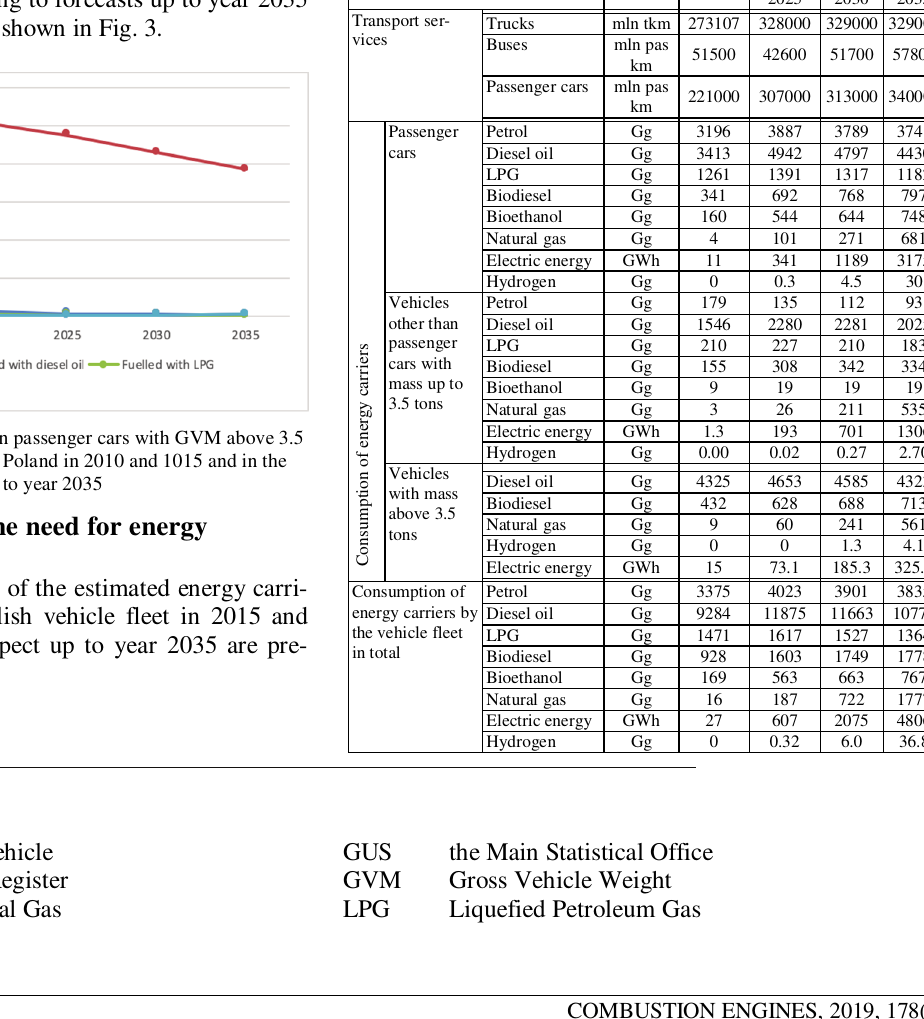
Table 1. Summary of the results of estimates regarding the consumption of energy carriers by the Polish vehicle fleet in the year 2035 Characteristics